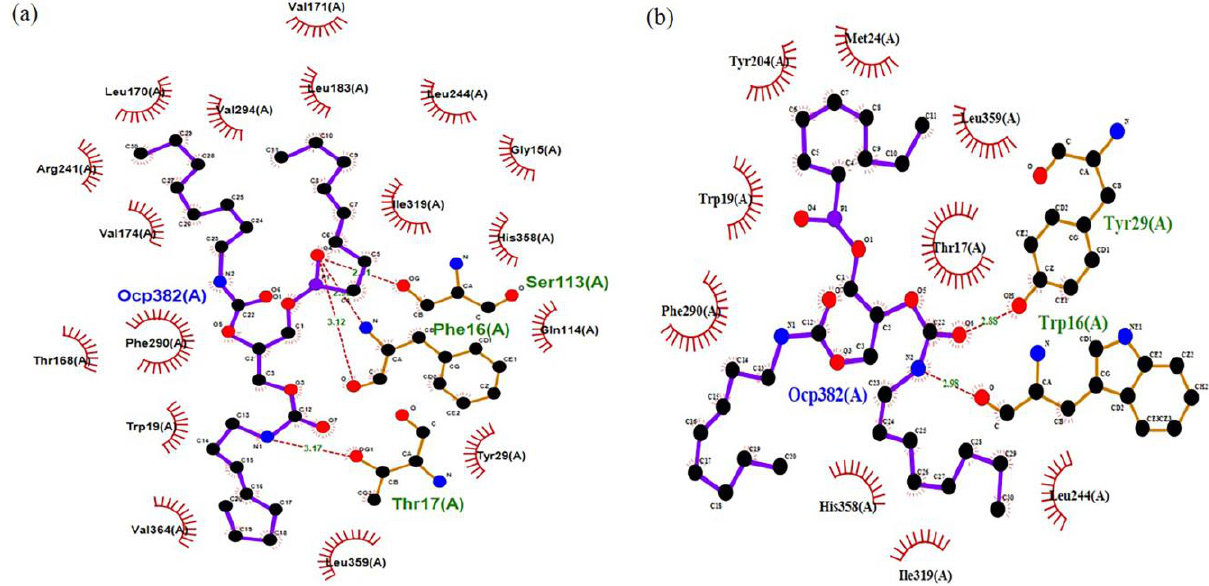
Figure 5. The 2D structure complex of wt-T1 and 3M variants with a substrate analogue OCP (RC-(RP, SP)-1,2-dioctylcarbamoyl-glycero-3-O-octylphosphonate). ( a ) wt-T1 lipase-OCP. ( b ) 3M lipase-OCP ( sn -3 modified regiospecific lipase). Hydrogen–bond interactions are shown as red dotted lines and ligands as purple and black.